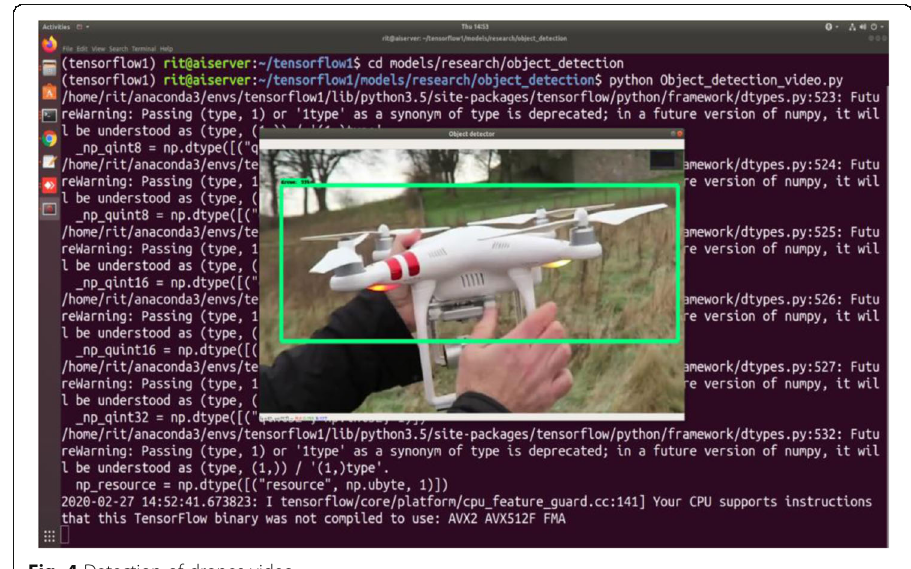
Fig. 4 Detection of drones video